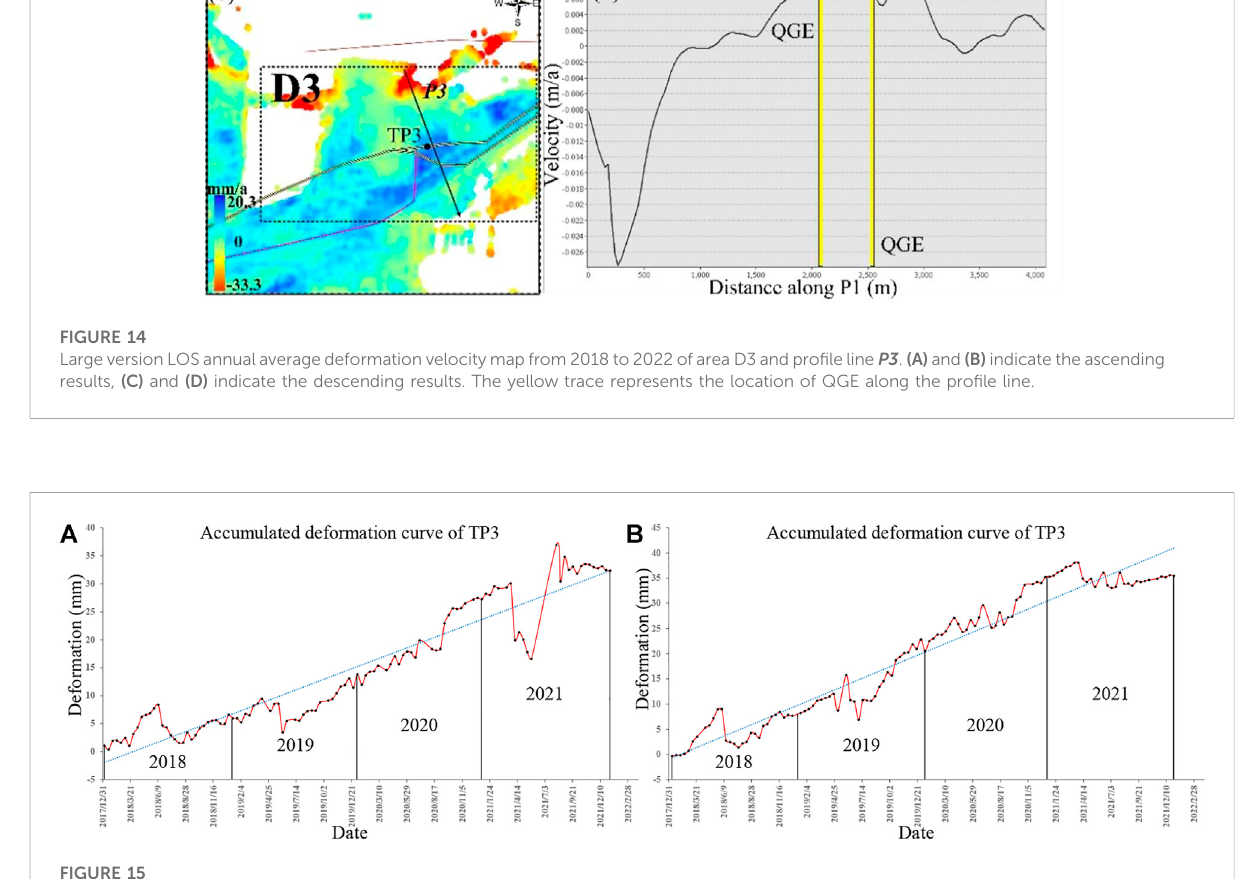
FIGURE 15 Time series deformation of TP3 on the QGE. (A) and (B) indicate the ascending and descending results,